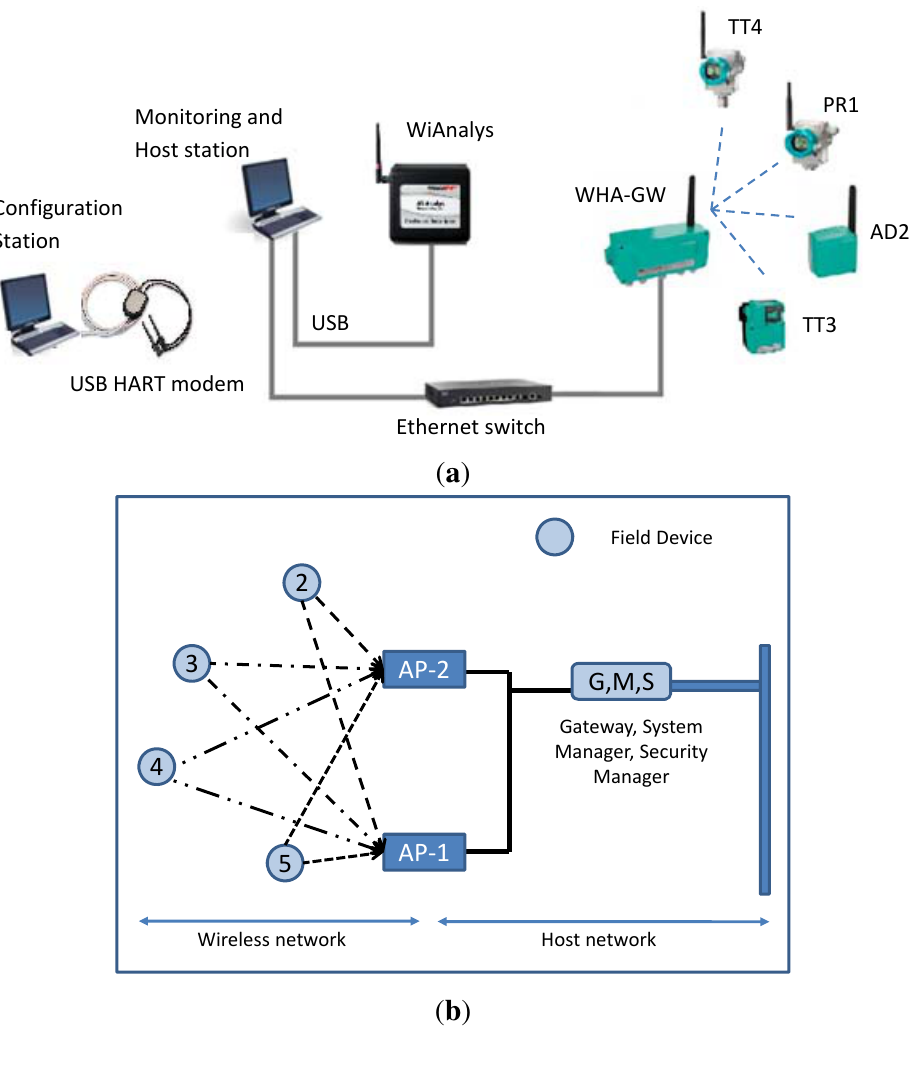
Real WirelessHART network Figure 10. Network topology for ( a ) real and ( b ) simulated setups. GW: gateway.